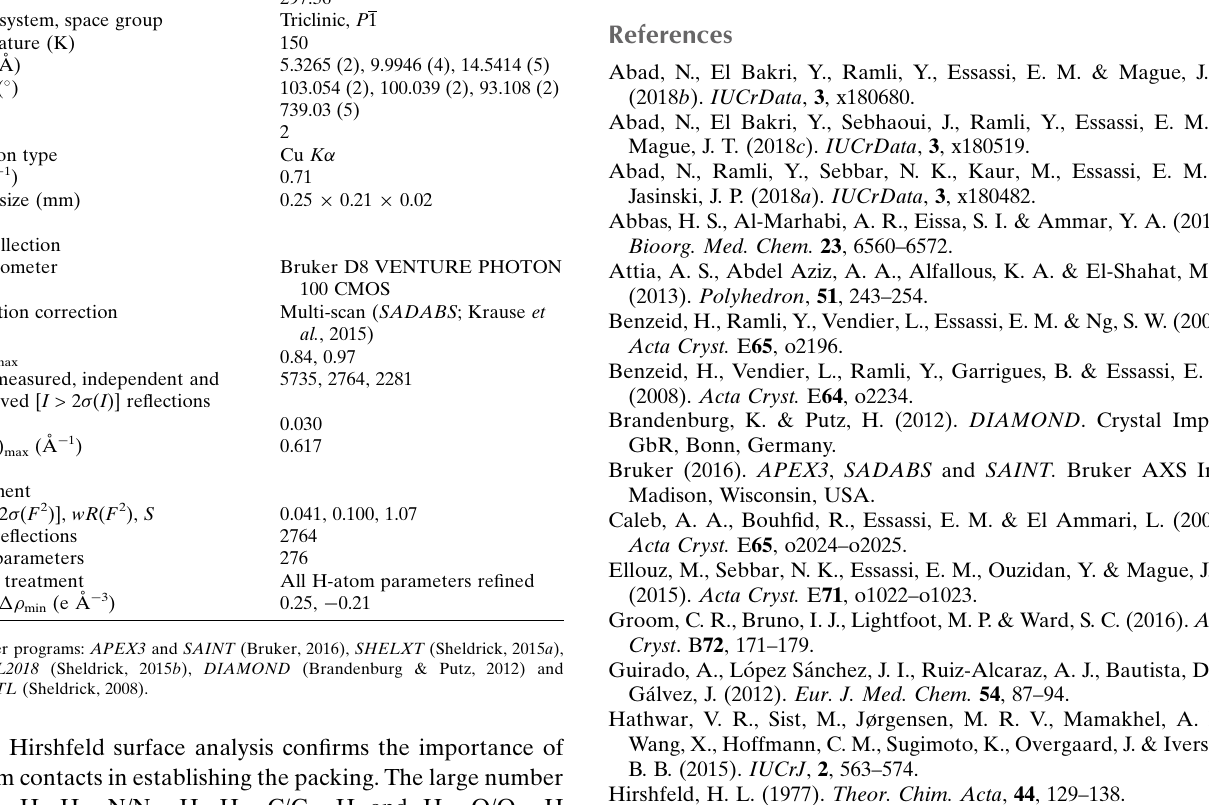
Table 3 Experimental details. Crystal data Chemical